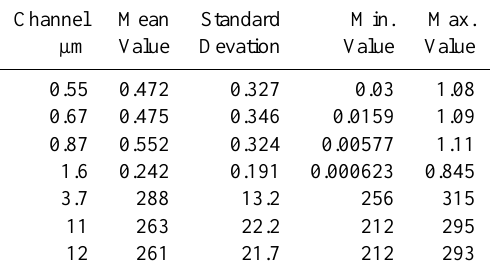
Table 4. This table summarises the ensemble of radiances consid- ered in the comparison between the fast forward model and DIS- ORT, the visible channel units are reflectance and the infrared chan- nel units are in Kelvin.